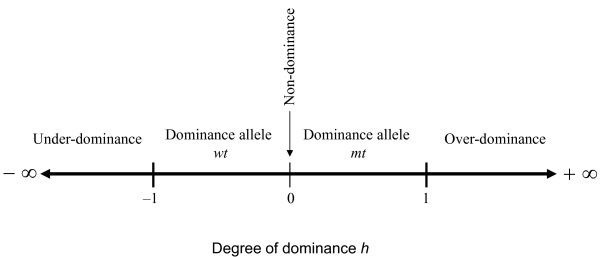
Snapshot of the degree of dominance according to the sign of h in order to facilitate the interpretation of results.